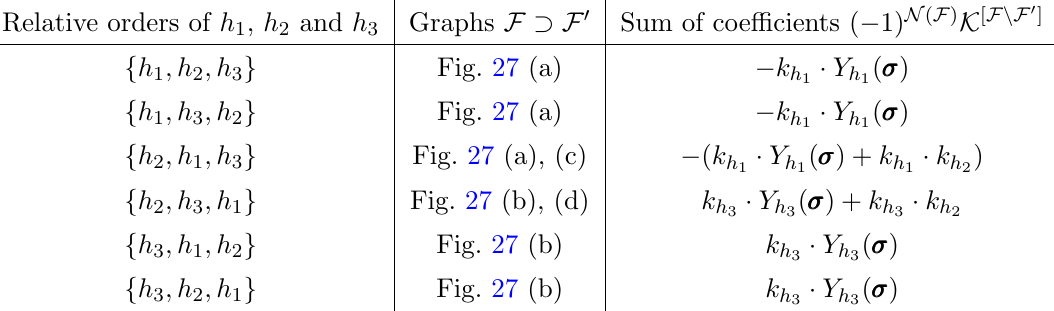
Table 3 . Consider the graphs in (cid:12)gure 27, which contain the skeleton F 0 = (cid:12)gure 6 (c).